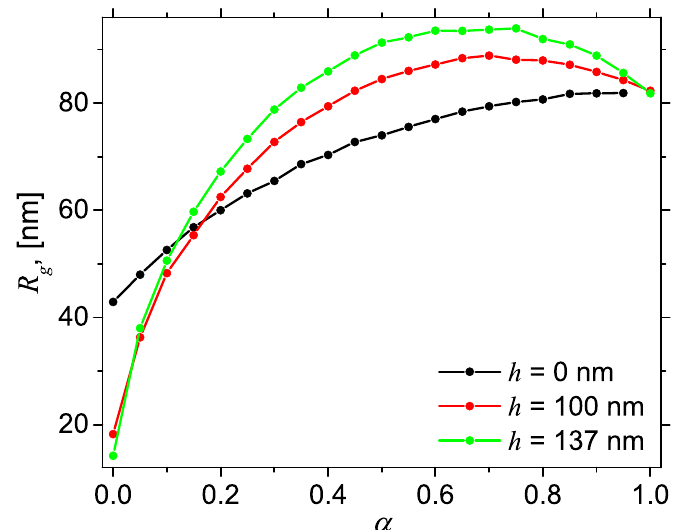
Figure 7. (Color online) Radius of gyration R g (black) of AnJPs with diameter 2 a = 40 nm and height 2 L 0 = 280 nm as a function of dimensionless parameter α (Equation (5)) for fixed values of the height h above middle-plane parallel to the bases (see Figure 3 for details): (Black) h = 0 nm; (Red) h = 20nm; and (Green) h =